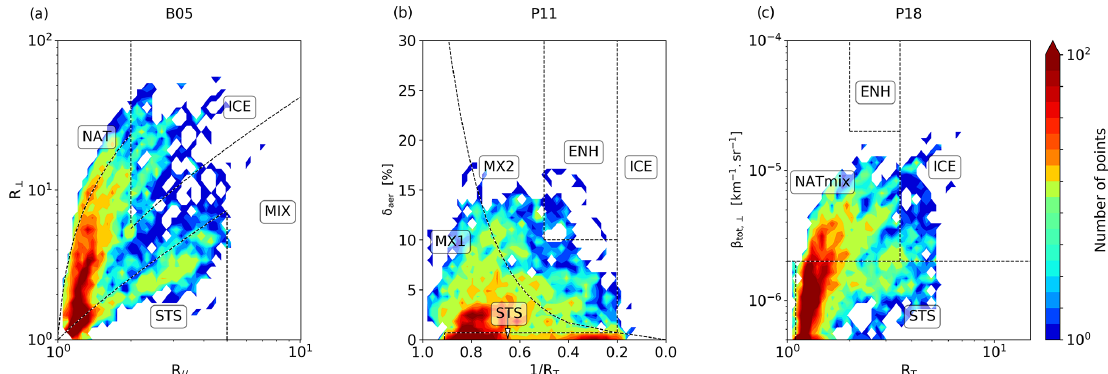
Figure 4. Distribution of the PSC measurements acquired at DDU between 2007 and 2020 based on the three classification schemes consid- ered: B05 (a) , P11 (b) and P18 (c) . The number of points per bin is colour-coded and each plot is based on a 5 × 50 bins grid.